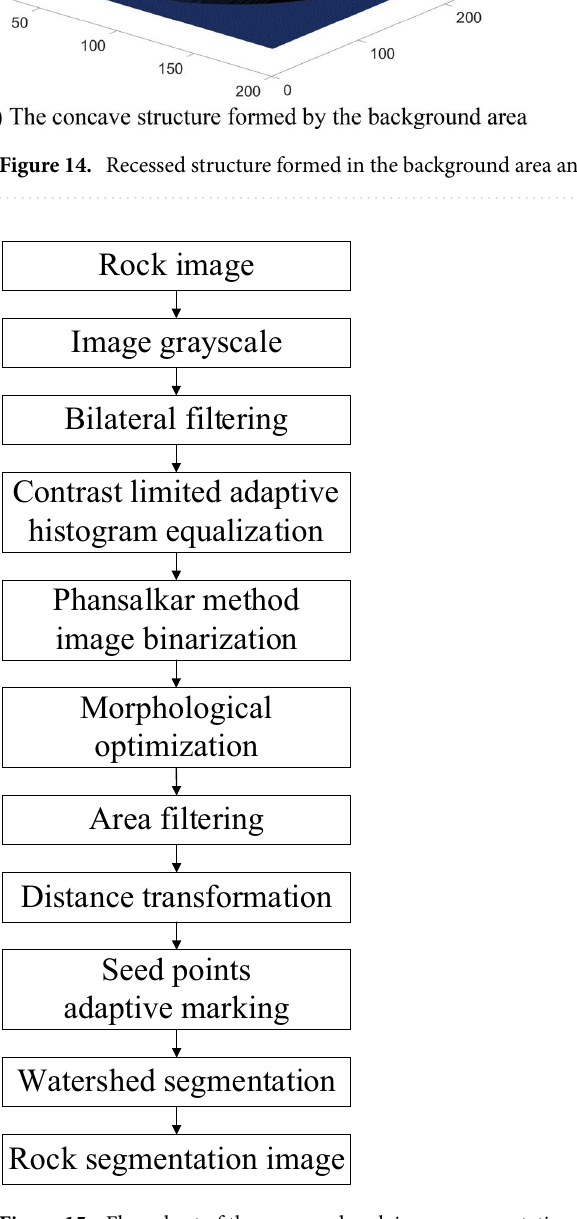
Figure 15. Flow chart of the proposed rock image segmentation